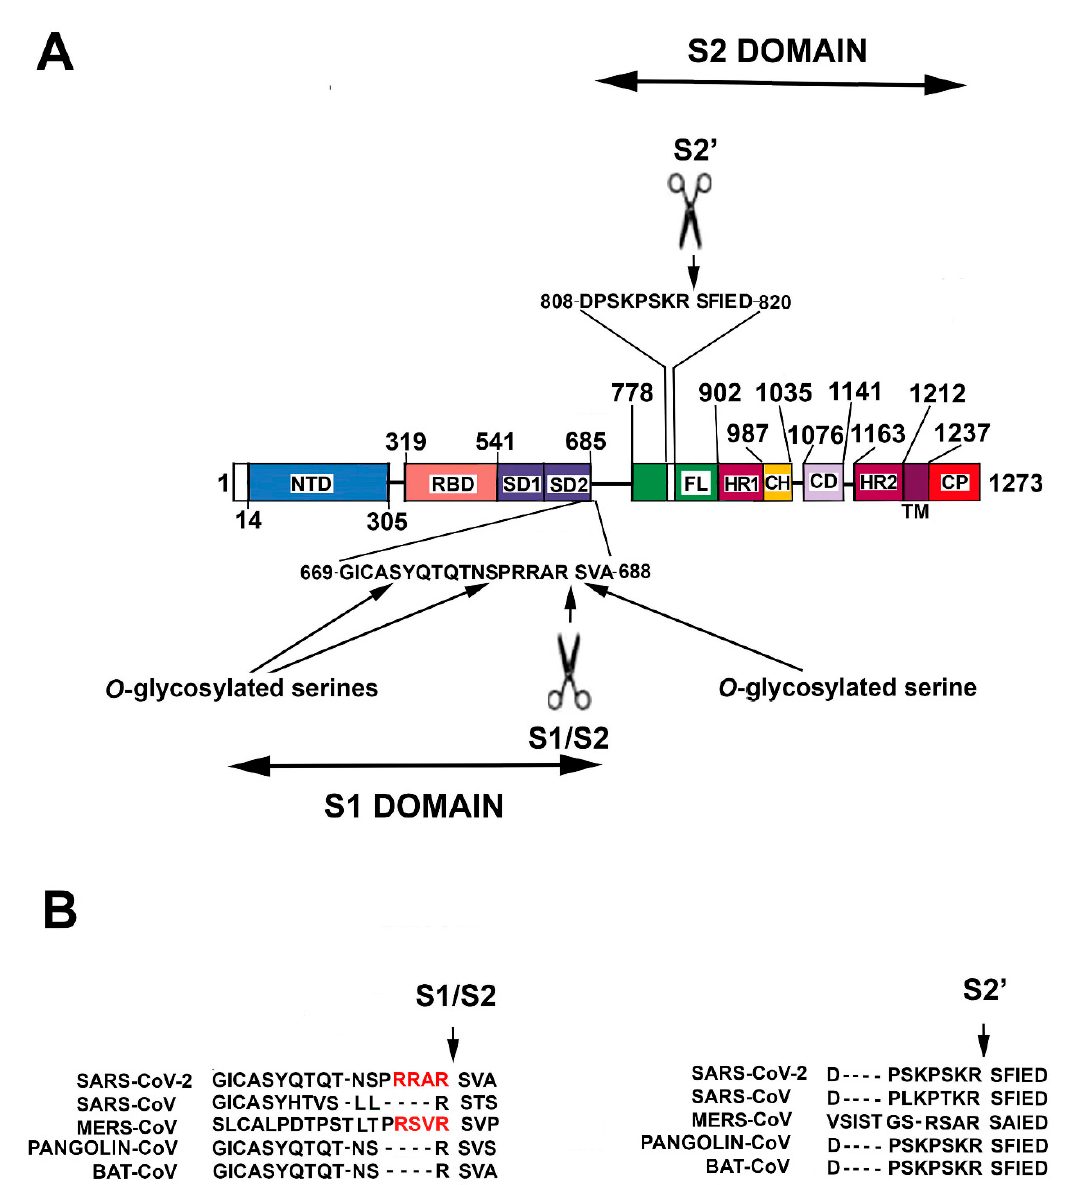
Figure 1. Domain organization and cleavage sequences of SARS-CoV-2 spike glycoprotein. ( A ) The domains of the protein are as the follows. S1 Domain: NTD (N-terminal domain), RBD (receptor binding domain), SD1 and SD2 (subdomain 1 and subdomain 2). S2 Domain: FL (fusion loop), HR1 (heptad repeat 1), CH (central helix), CD (connector domain), HR2 (heptad repeat 2), TM (trans-membrane domain), CP (cytoplasmic tail). The panel also reports the position of the residues A comparison among SARS-CoV-2, SARS-CoV, MERS-CoV, Pangolin-CoV, and Bat-CoV is also reported. Red color highlights the polybasic sequence of SARS-CoV-2 and MERS-CoV (see text for details).